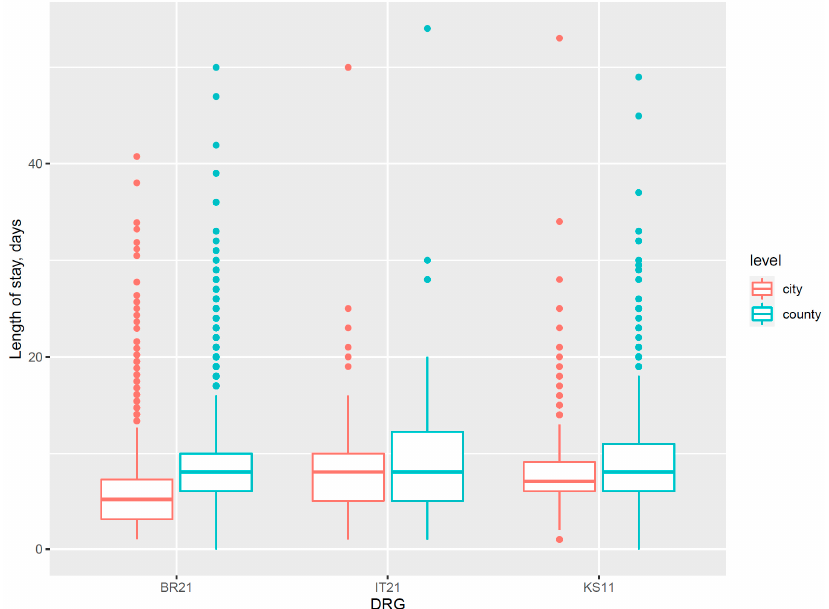
Figure 2. Box plot for differences in length of stay between city and county hospitals in DRG with a significant difference in pressure ulcer rate. DRG: diagnosis-related group; BR21: the DRG of cerebral ischemic diseases with severe comorbidities; IT21: the DRG of chronic inflammatory musculoskeletal and connective tissue disorders with severe comorbidities; KS11: the DRG of diabetes with severe comorbidities.